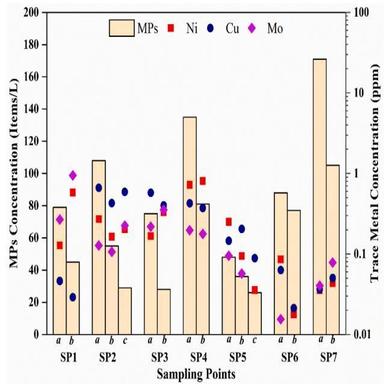
MPs and trace metals concentration in GW at different depths and sampling points (SP).